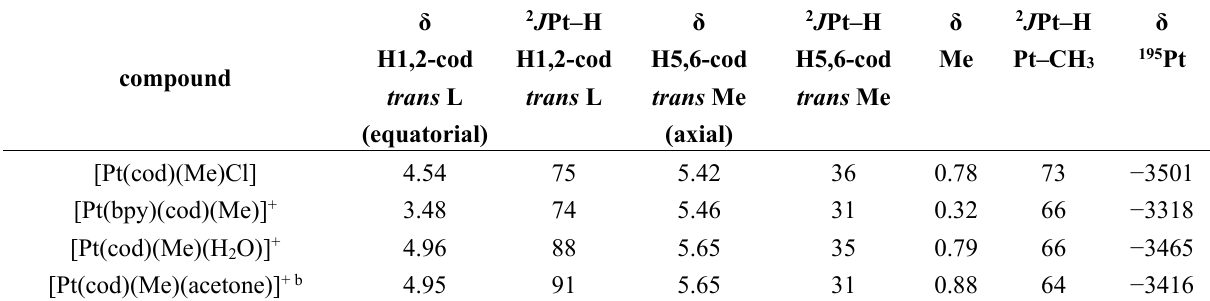
Table 2. Selected 1 H and 195 Pt NMR data of cod platinum complexes a .